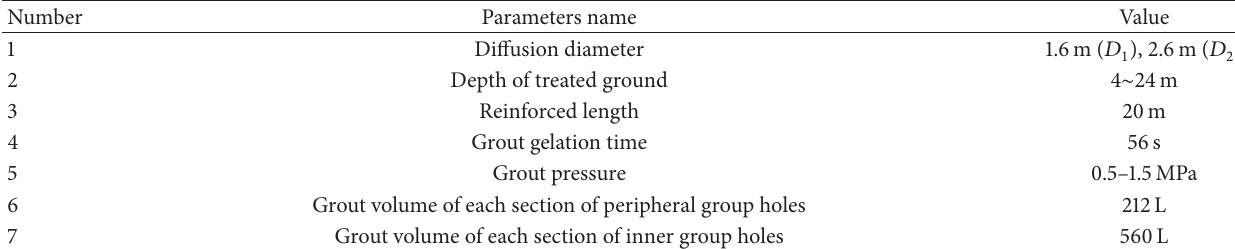
Table 2: Preliminary grouting